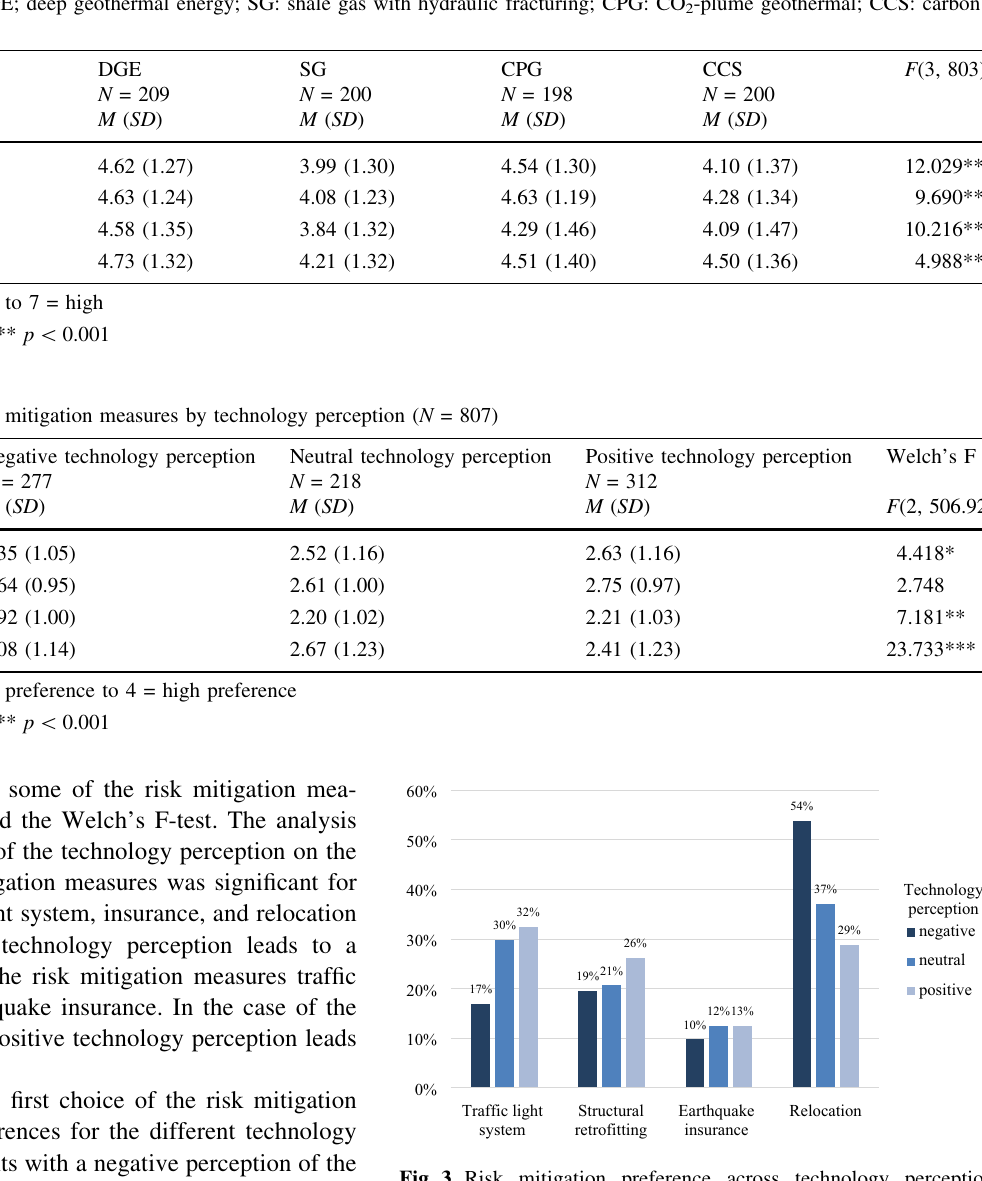
Table 3 Risk mitigation perception (overall score across the four individual criteria necessity, effectiveness, safety, technology approval) by technology ( N = 807)—DGE; deep geothermal energy; SG: shale gas with hydraulic fracturing; CPG: CO 2 -plume geothermal; CCS: carbon capture and storage